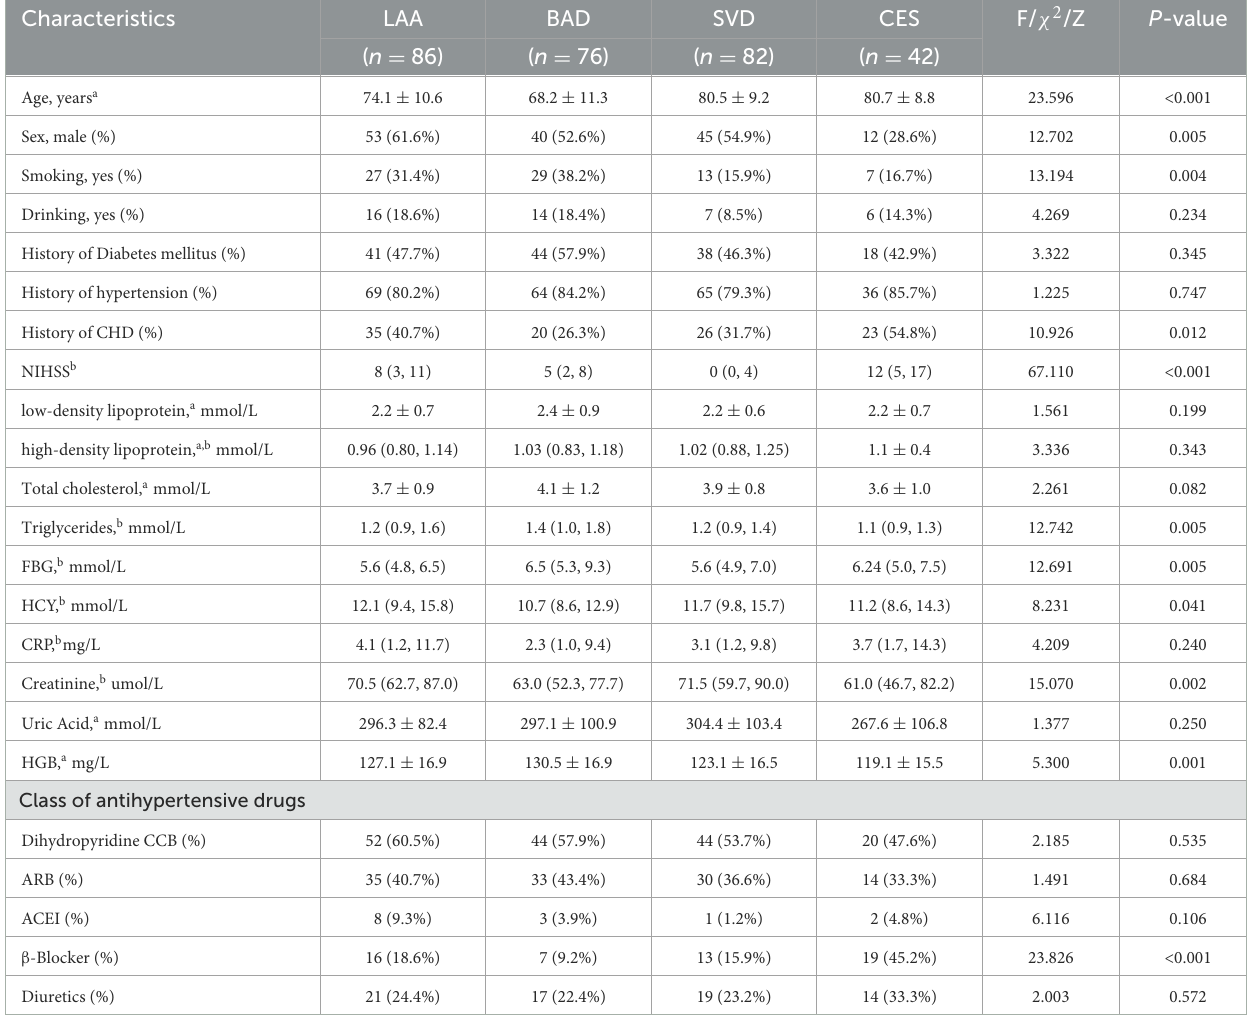
TABLE 1 General characteristics of all subjects in the four ischemic stroke subtypes.